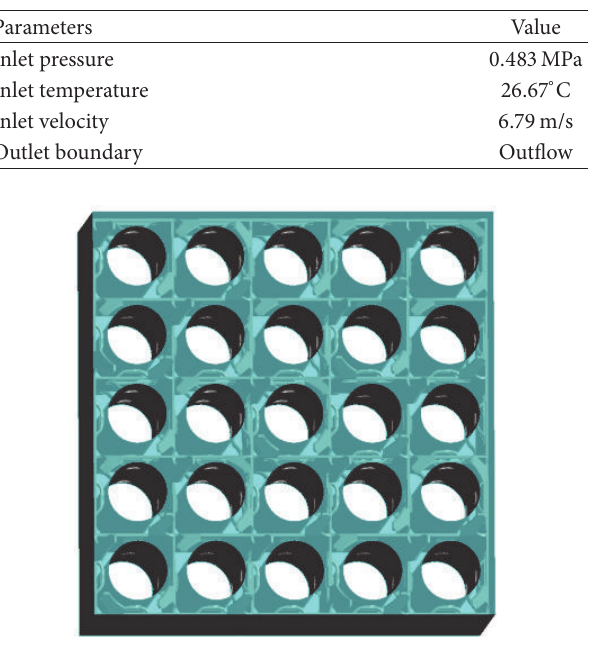
Figure 3: AFA2G grid.